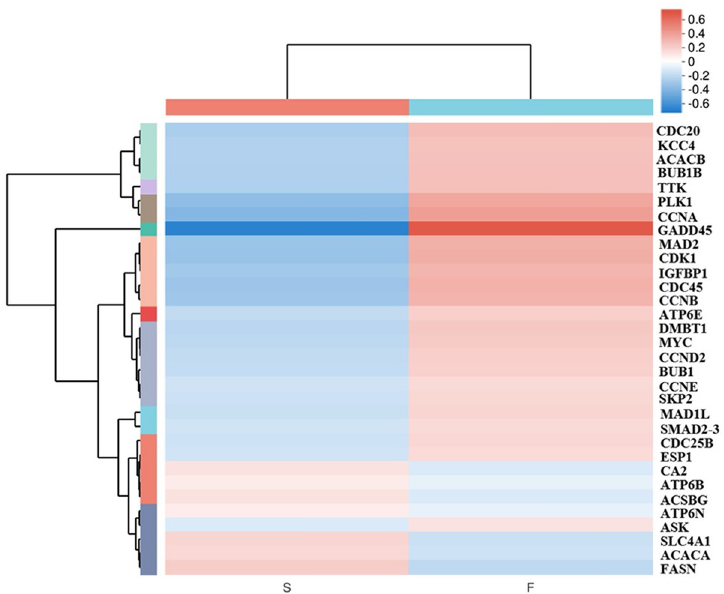
Fig 4. Hierarchical cluster analysis of DEGs involved in the growth superiority. Red and blue gradients indicate the up- and down- regulation of DEGs, respectively.